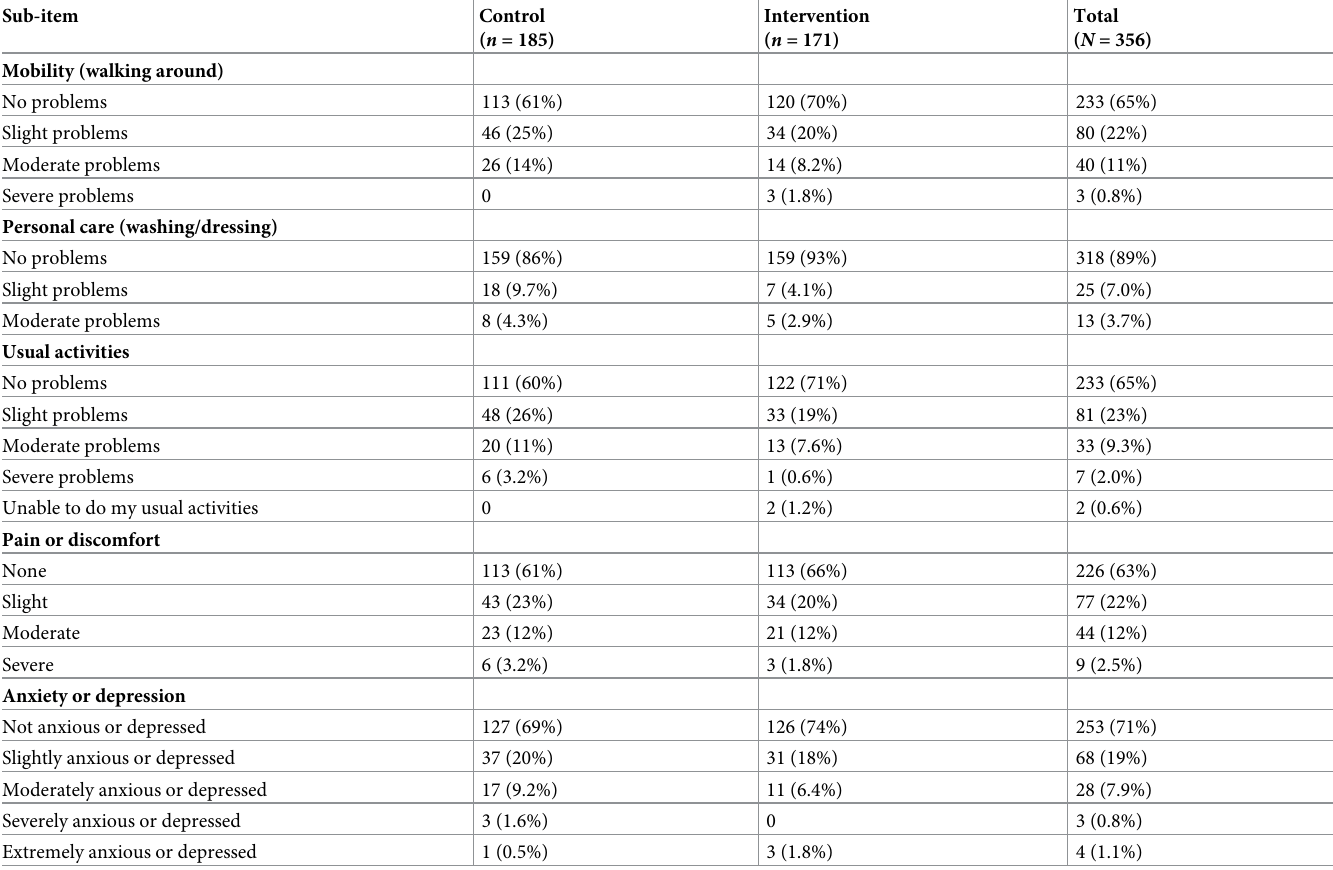
Table 4. EQ-5D sub-item data at